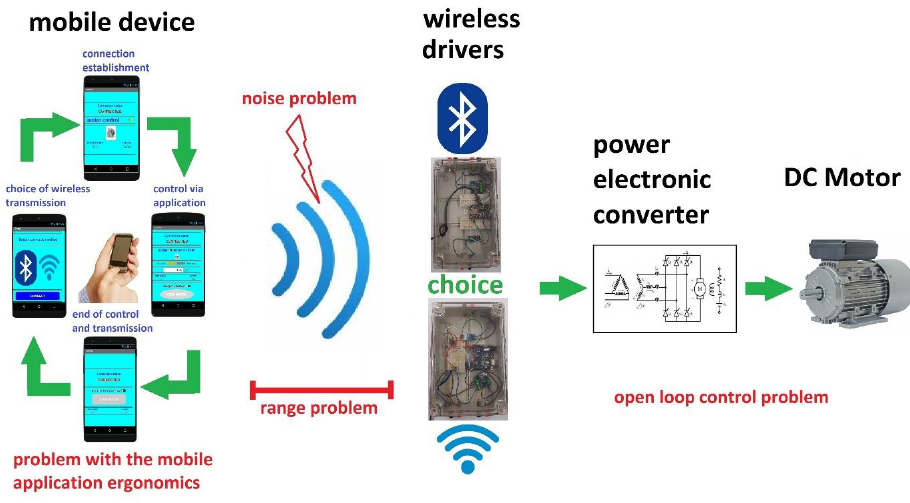
Figure 1. Schematic diagram of an open-loop remote control system of a DC electric drive.